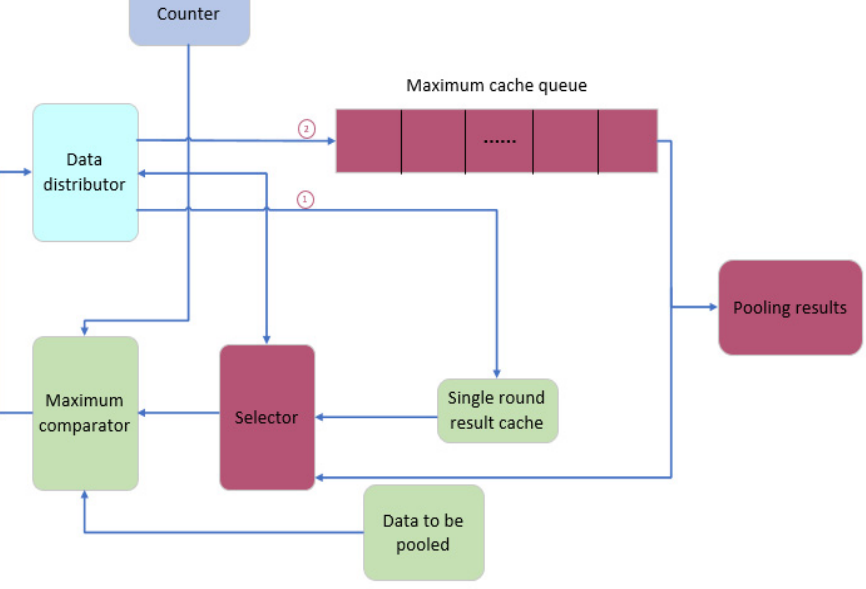
Figure 8. Structure of the pooling circuit.